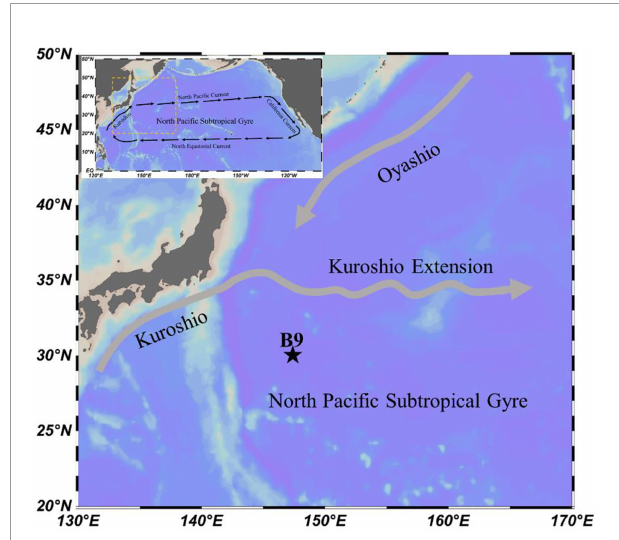
FIGURE 1 | Study region and sampling